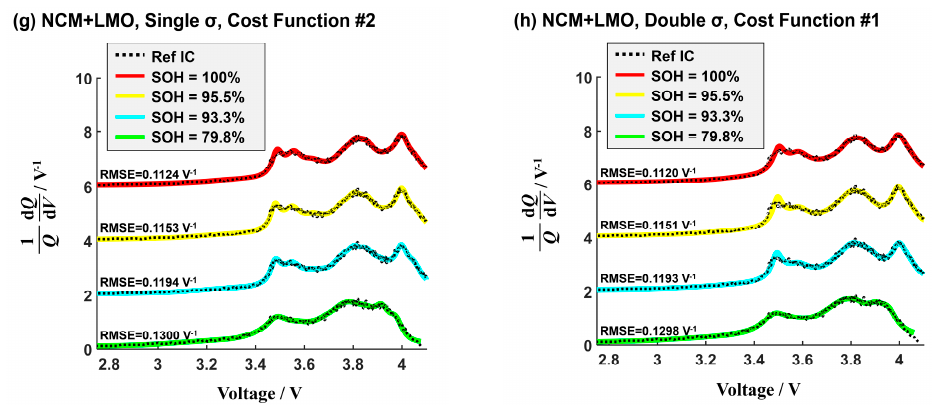
Figure 11. ICA for characterizing the degradation of lithium-ion batteries using the SVR algorithm. ( a ) Cell A with LFP cathode, single σ + Cost Function #2; ( b ) Cell A with LFP cathode, double σ + Cost Function #1; ( c ) Cell B with LFP cathode, single σ + Cost Function #2; ( d ) Cell B with NCM cathode, double σ + Cost Function #1; ( e ) Cell C with LFP cathode, single σ + Cost Function #2; ( f ) Cell C with LFP cathode, double σ + Cost Function #1; ( g ) Cell D with NCM+LMO cathode, single σ + Cost Function #2; ( h ) Cell D with NCM+LMO cathode, double σ + Cost Function #1.